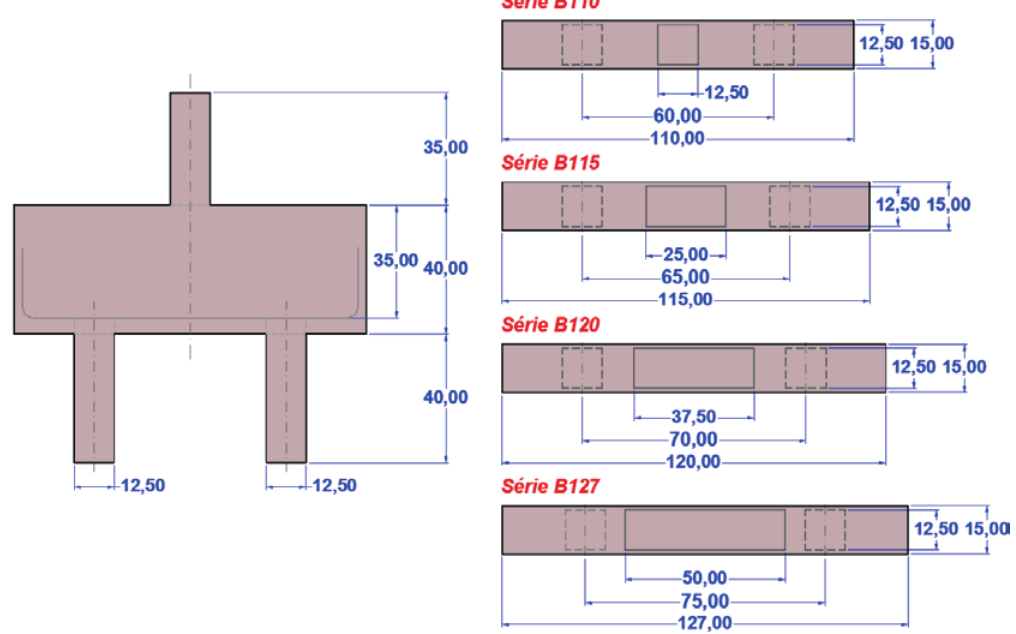
Main measures (cm) of the experimental pile